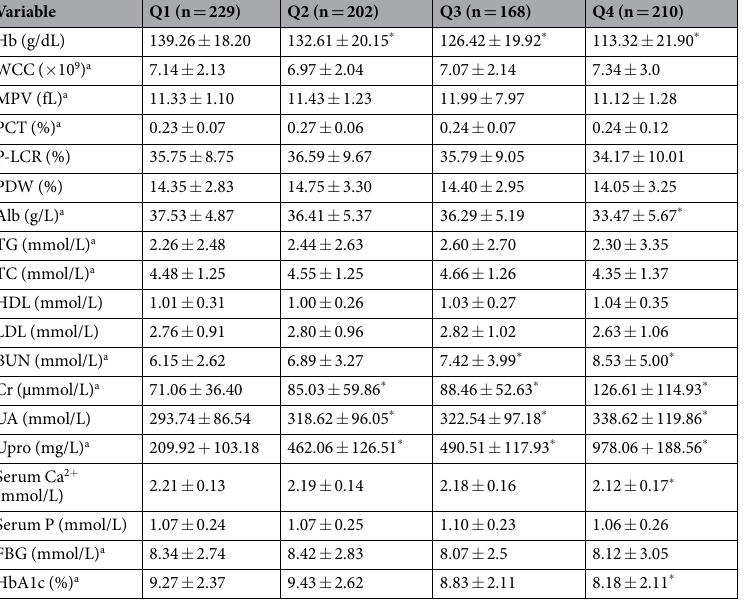
Table 2. Blood and urine examinations of Q1 to Q4 in T2D patients. Notes: T-test for comparing the difference from Q1 to Q4; a The distribution of the variables did not follow normal distribution, so the non-parametric Kruskal-Wallis test was used; * P < 0.05 compared to Q1 group. Abbreviation : Hb, hemoglobin; MPV, mean platelet volume; HbA1c, glycosylated hemoglobin; WCC, white cell count; MPV, mean platelet volume; PCT, plateletcrit; P-LCR, plate–large cell ratio; PDW, platelet distribution width. Alb, serum albumin; TG, triglyceride; TC, total cholesterol; HDL, high density lipoprotein; LDL, low density lipoprotein; BUN, blood urea nitrogen; Cr, serum creatinine; UA, uric acid; Upro, urinary protein excretion; FBG, fasting blood